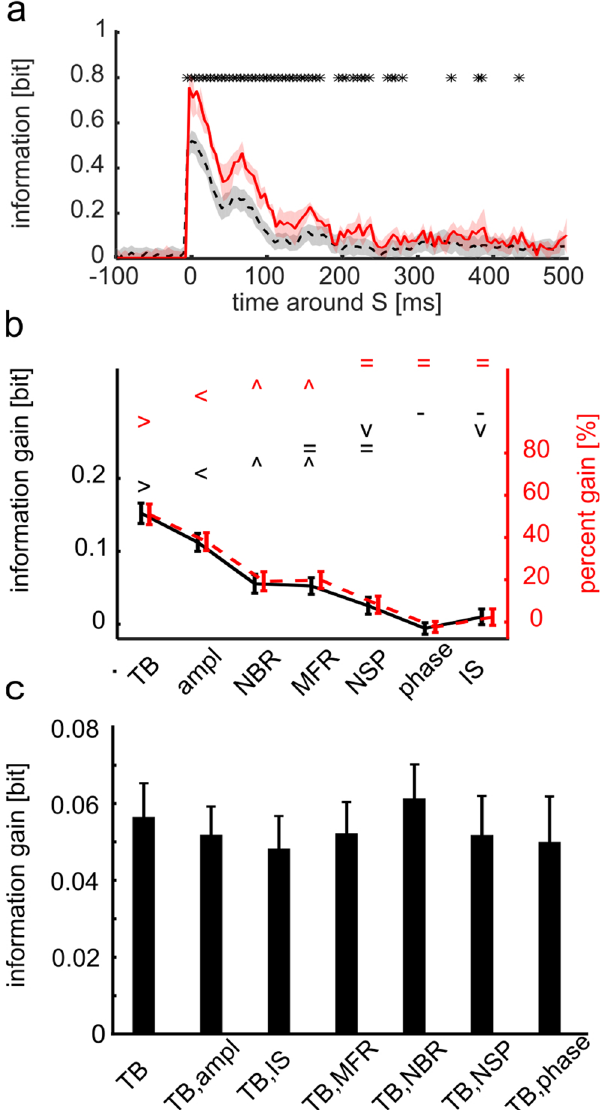
Figure 2. Post-stimulus response carries higher information about the stimulus when considered together with pre-stimulus state variable θ . ( a ) Time course of the across-sessions average (n = 5) of the information I ( S ; R , Θ ) about stimuli carried by responses R and state variables Θ = TB (red solid line) and the across-sessions average of the information I ( S ; R )computed when destroying the information in the variable Θ by shuffling its values across trials (black dashed line). The red area delimits SEM across sessions of I ( S ; R , Θ ). The grey area around I ( S ; R ) delimits the area between the 5th and 95th percentiles of the average across sessions of the distribution I ( S ; R , Θ SH ) obtained with N = 200 random permutations of state variables Θ across trials. Stars indicate time points in which I ( S ; R , Θ ) is significantly higher than I ( S ; R ) (one-tailed permutation test, p < 0.05 FDR corrected). ( b ) Mean and SEM across experiments of information gain (black line) and percentage information gain (red dashed line) in a [0 100] ms time window after the stimulus, for different state variables. Symbols { > < ^ = − } mark data groups that have similar means (Tukey’s HSD, p < 0.05), see Supplementary Information. Black and red symbols indicate not significantly different means for, respectively, information gain (F(6, 639) = 76.06, p = 10 − 73 one-way between subject ANOVA followed by Tukey’s HSD multiple comparison test) and percentage information gain (F(6, 639) = 46.84, p = 10 − 48 , same test). State variable TB has information gain and percentage information gain significantly higher than other considered state variables. ( c ) Mean and SEM across experiments of the decoded information gain summed in a [0 100] ms time window after the stimulus, for the TB state variable and corresponding bi-dimensional state variables (where TB is paired with either ampl, IS, MFR, NBR, NSP and phase). There are no significant different sessions averages of decoded information for any comparison between bi-dimensional and one-dimensional state variables (F(6, 28) = 0.18 with p = 0.98, one-way between subject